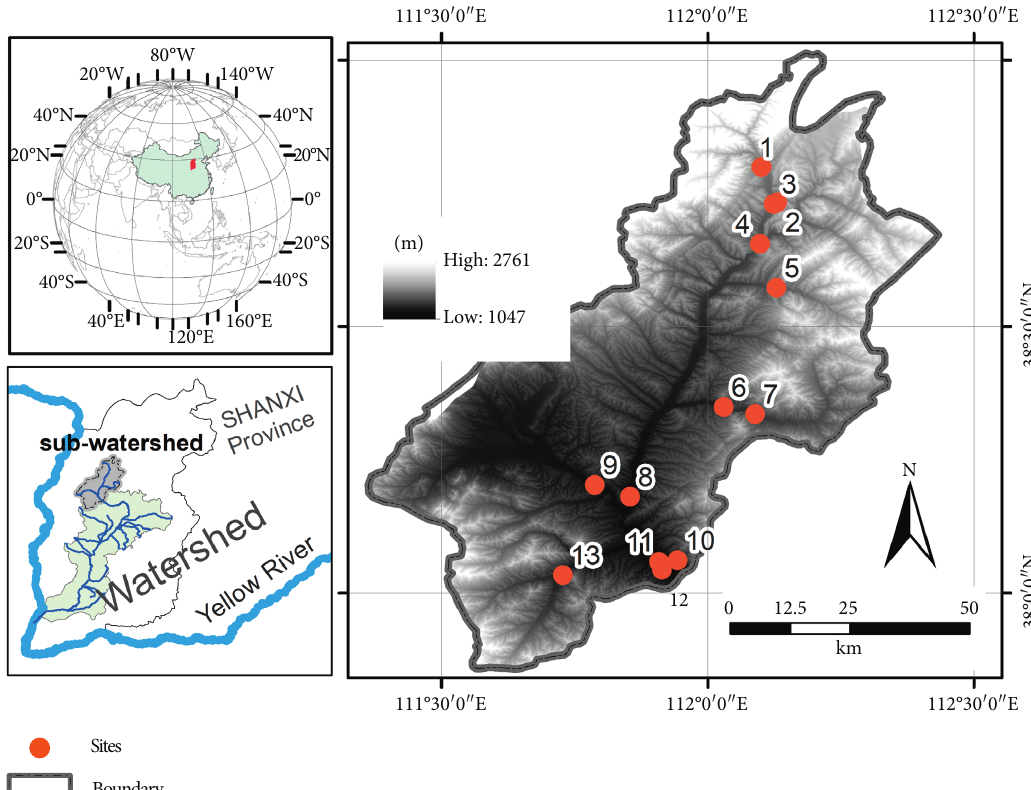
Figure 1: Locations of the sampling sites in study area. S1: Leiming Temple; S2: the entrance to Yellow River water diversion junction of Toumaying village; S3: the outlet of Yellow River water diversion junction of Toumaying village; S4: the junction of Honghe River; S5: Mingshuihe River; S6: Jingle county; S7: Dongnianhe River; S8: Hecha village; S9: Quli county; S10: the inlet of Fenhe Reservoir; S11: the middle part of Fenhe Reservoir; S12: the outlet of Fenhe Reservoir; S13: Jianhe River